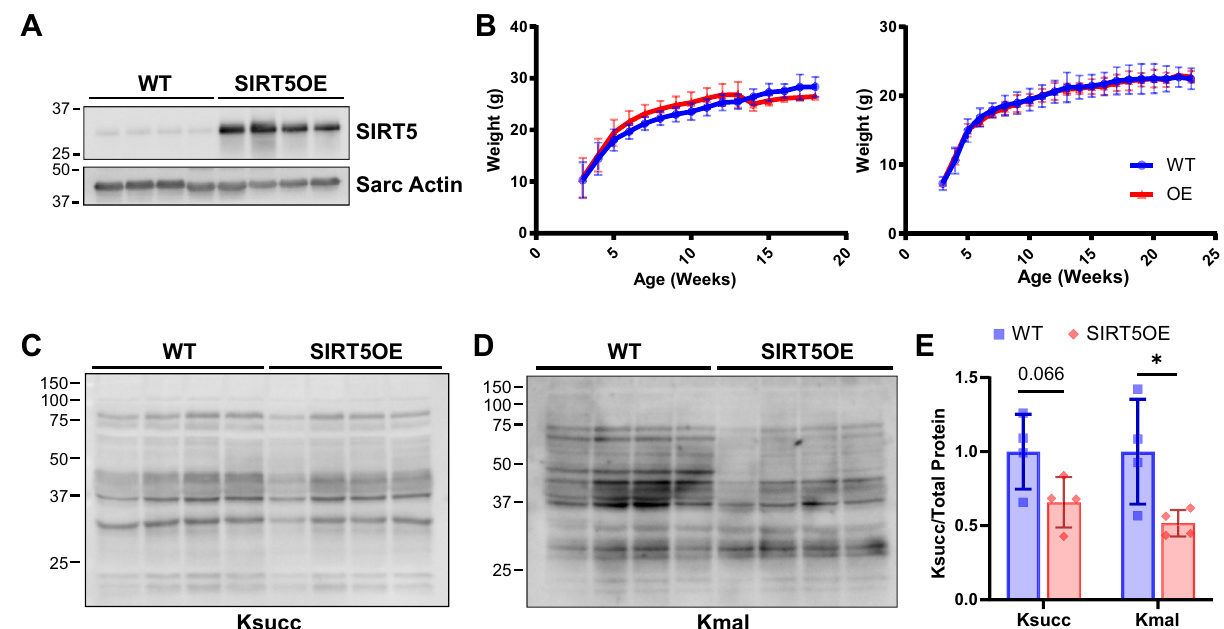
Figure 1. SIRT5OE mice exhibit decreased mildly decreased cardiac lysine malonylation. (A) Immunoblot analysis of SIRT5 expression in heart samples presented in c-e. Original immunoblot images are presented in Supplemental Fig. 7A. (B) Weight (g) of WT and SIRT5OE male and female mice with age. (C-E) Representative immunoblot analysis of succinyl-lysine (Ksucc), and malonyl-lysine (Kmal) levels in WT and SIRTOE hearts, with quantification. Original immunoblot images are presented in Supplemental Fig.